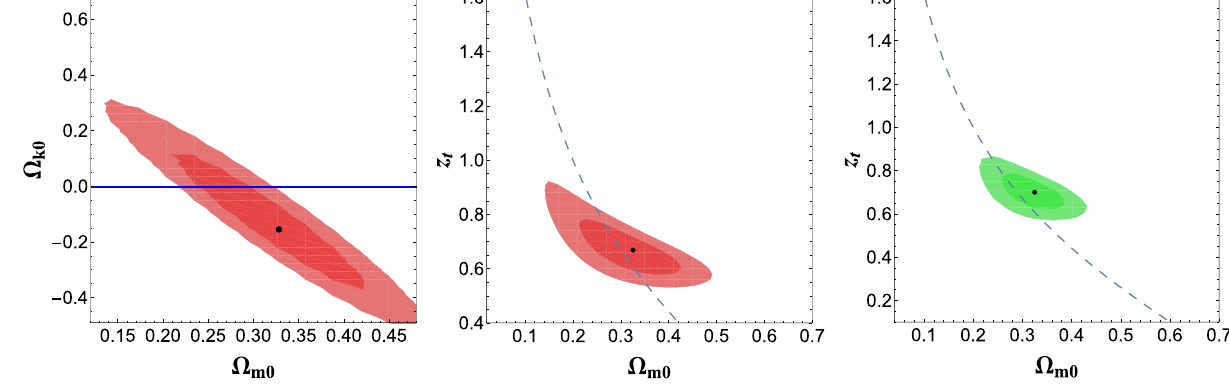
parameter space studied in the reference [65] and on the right we show thejointdataobservationalconstraints.Thegreendashedlinerepresents the universe with flat